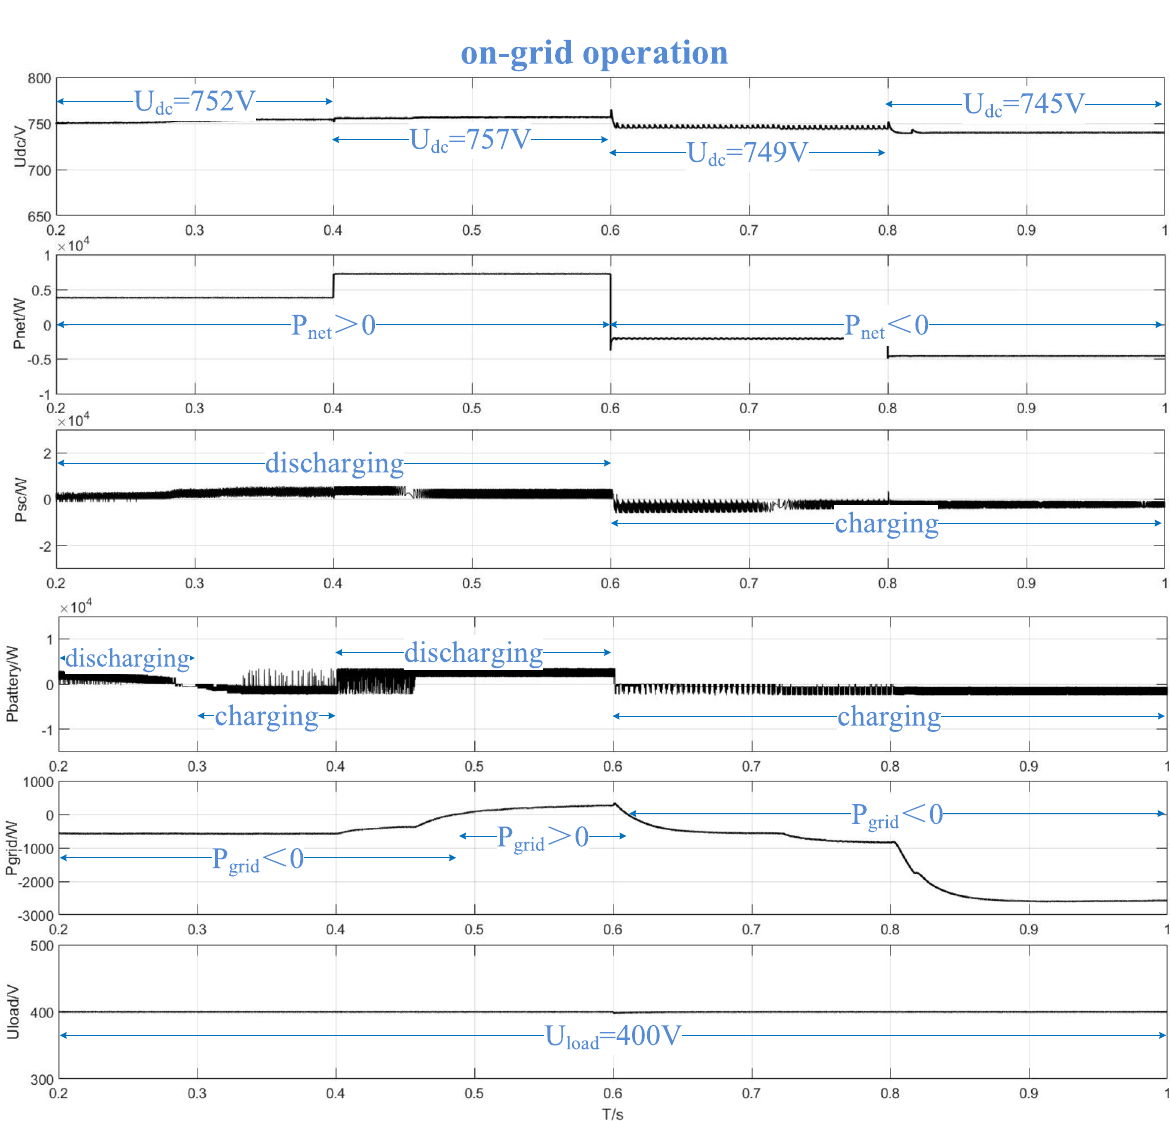
Fig. 12 Simulation results of on-grid